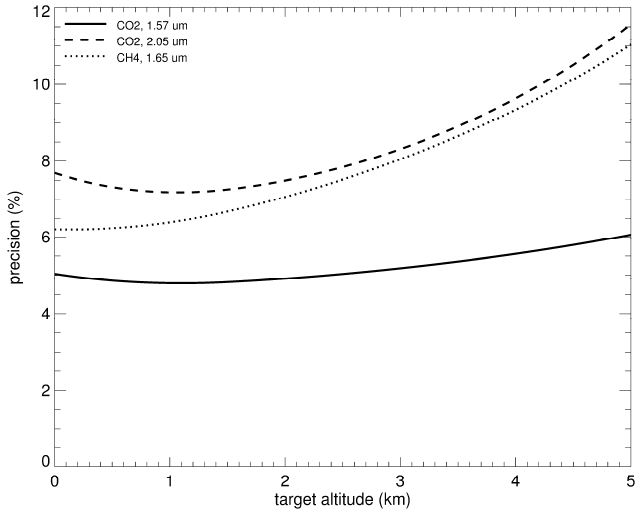
Figure 3. Simulated space Lidar mixing ratio precision (random instrument noise; one-sigma) as function of reflecting surface altitude for CO 2 at 1.57 and 2.05 µm and for CH 4 at 1.65 µm under the conditions of Tables 1 and 2.